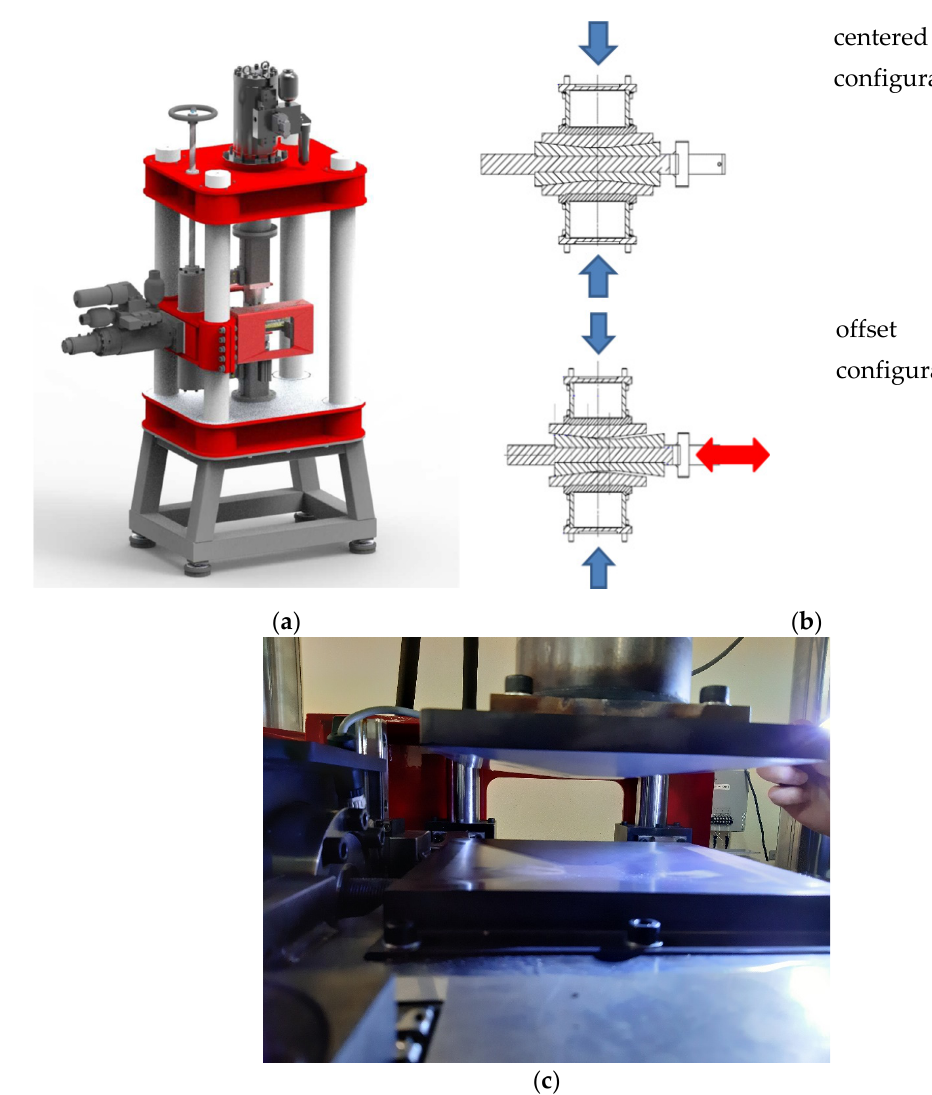
Figure 5. Experimental apparatus: ( a ) biaxial testing machine; ( b ) specimen setup; ( c ) picture of the specimen installed on the testing machine, with close-up of convex and concave